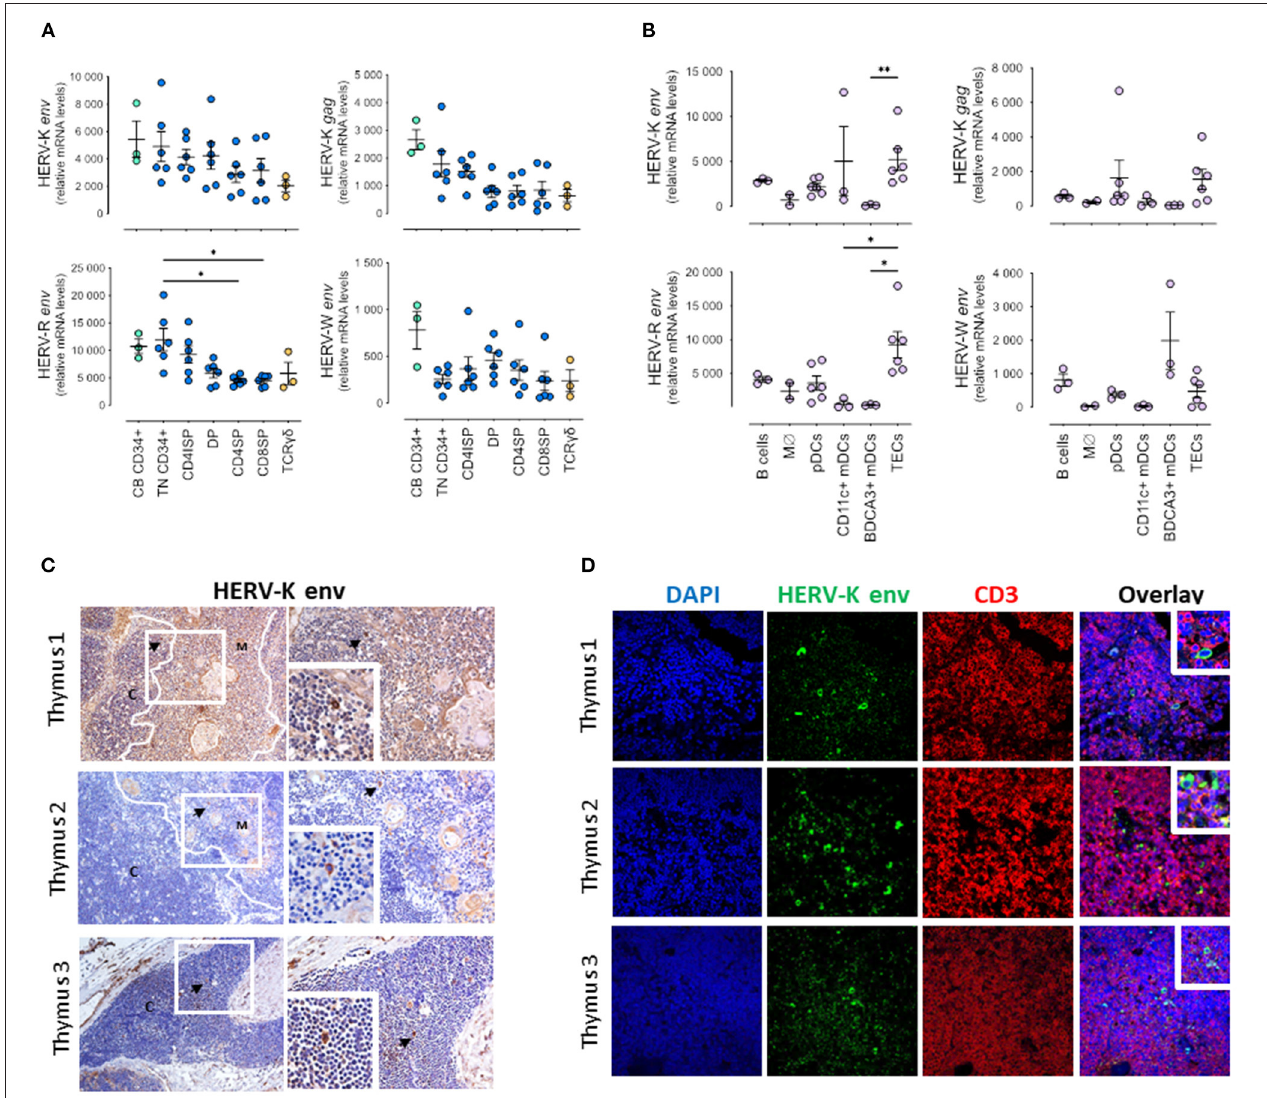
FIGURE 1 | HERV expression in pediatric thymuses . Relative transcriptional levels of HERV-K, -W, -P and -R env normalized to β -actin expression levels in sort-purified: (A) CD34 + cells from cord blood, thymocyte subsets along T cell development (TN, Triple Negative; CD4ISP, Immature Single Positive CD4; DP, Double Positive; CD4SP, CD4 Single Positive and CD8SP, CD8 Single Positive) and γ δ thymocytes; (B) Major non-T cell populations in the thymus, namely B cells, monocytes/macrophages (M φ ), plasmacytoid dendritic cells (pDCs), both CD11c + and BDCA3 + myeloid dendritic cells (DCs), and thymic epithelial cells (TECs); each dot represents one different thymus; results were compared using Kruskal-Wallis with Dunn’s multiple comparisons test; * P < 0.05; ** P < 0.001. (C) HERV-K Env protein expression evaluated by immunohistochemistry; left images amplification 200x; right images amplification 400x; Digital zoom insert - the image down to a centered area with the same ratio as the original; black arrows indicate positive cells stained in brown; white lines shows delimitation cortex/medulla area; C, Cortex; M, Medulla. (D) Double staining for HERV-K Env protein and CD3 by immunofluorescence; image amplification 400x; Digital zoom insert - the image down to a centered area with the same ratio as the